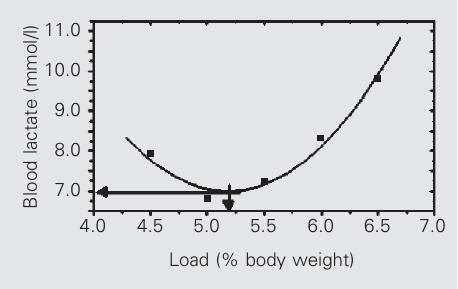
Figure 1. Determination of the blood lactate minimum (BLM) of a single rat during an incremen- tal swimming exercise test. Each point indicates blood lac- tate concentration (mmol/l) on the ordinate after a 5-min exer- cise bout with the animal sup- porting each load indicated on the abscissa. The BLM and the respective workload were calcu- lated using the spline function. The vertical arrow indicates the estimated workload correspond- ing to BLM while the horizontal arrow indicates the interpolated blood lactate